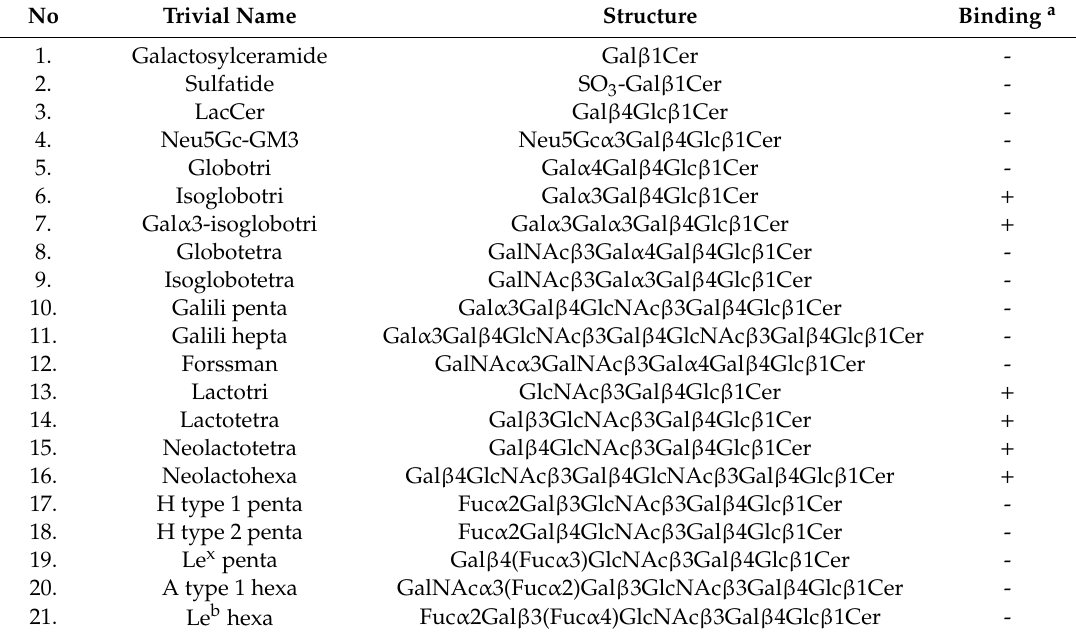
Table2. Bindingof C.matruchotii